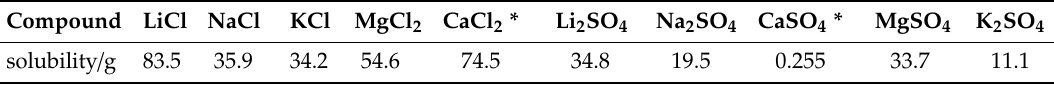
Table 4. The solubility of all the chloride and sulfate exist in the collected retentate. Compound LiCl